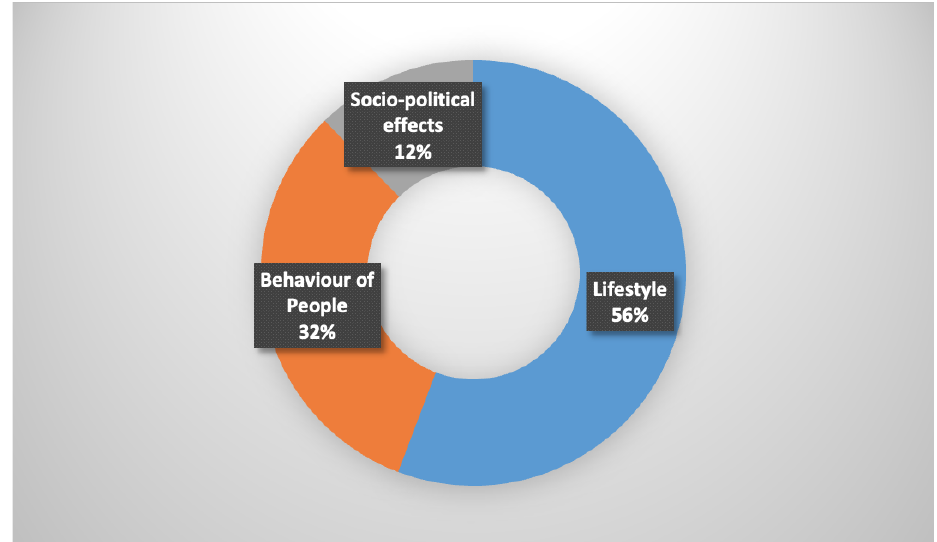
Chart 4: Occurrences of Neologisms in hashtags based on their Categories